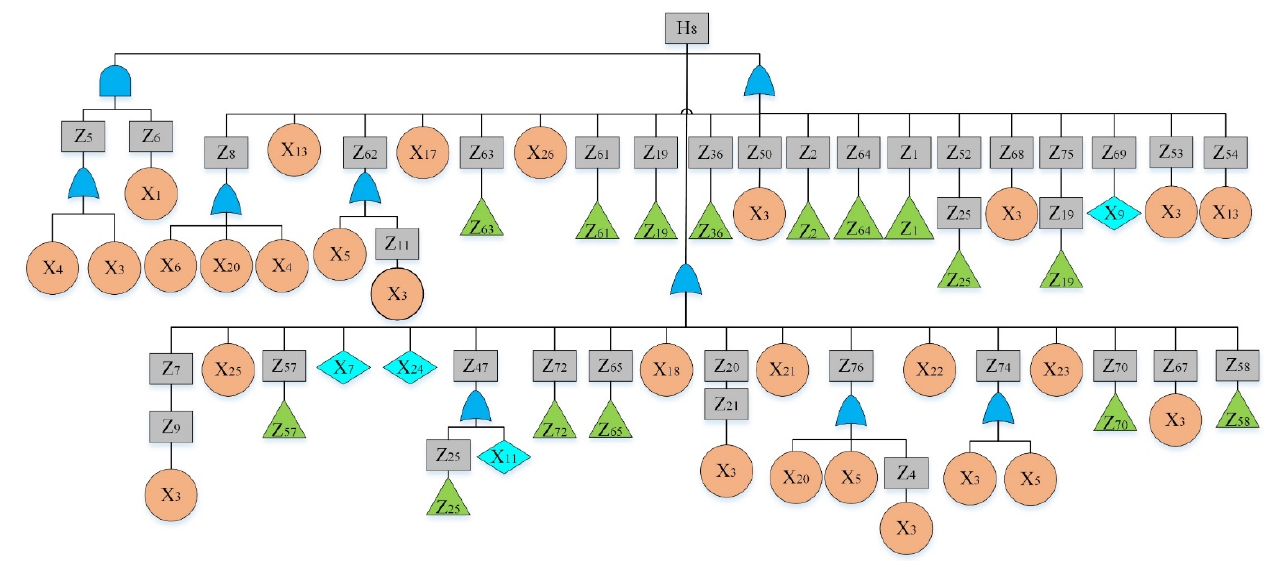
Figure 9. Fault tree of a hydraulic system: sub-tree VII.